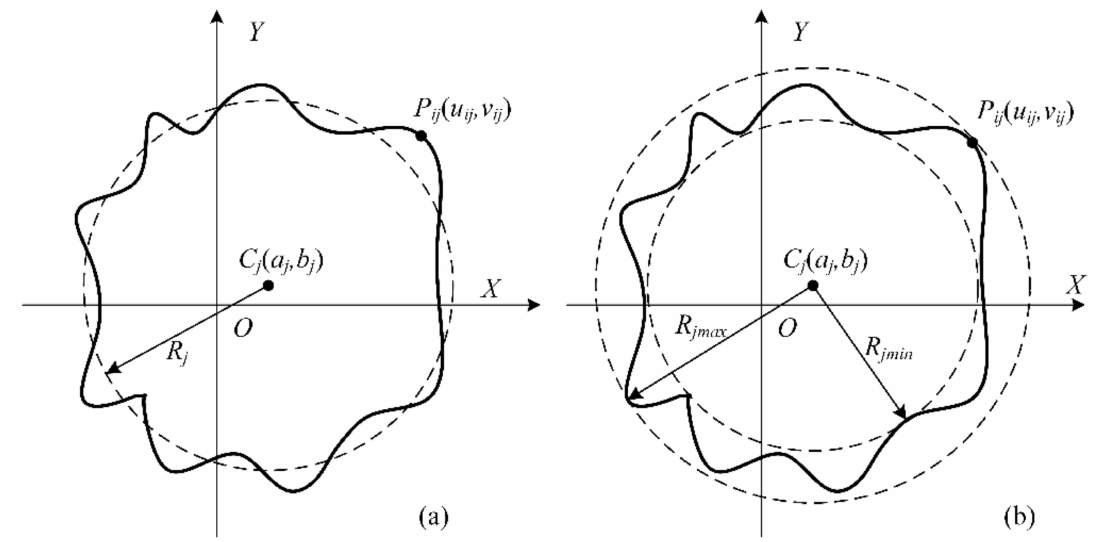
Figure 8. Calculation method of the circle center in roundness error evaluation: ( a ) least-squares circle (LSC), ( b ) minimum zone circle